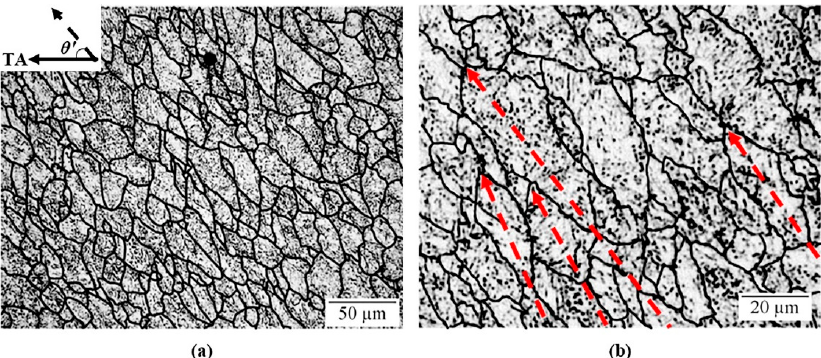
Figure 12. LOM micrographs of the prior austenite microstructures produced via Low T Finish simulations and quenched after the fourth finishing deformation step (F4): ( a ) lower and ( b ) higher magnification. The 0.724 radial position is shown in both. The torsional axis (TA) is horizontal to the page. Dashed lines in ( b ) show the inclination angles of various prior austenite grains. Etched with a modified Béchet–Beaujard reagent, and prior austenite grain boundaries are highlighted in black. Metals 2020 , 10 , 334